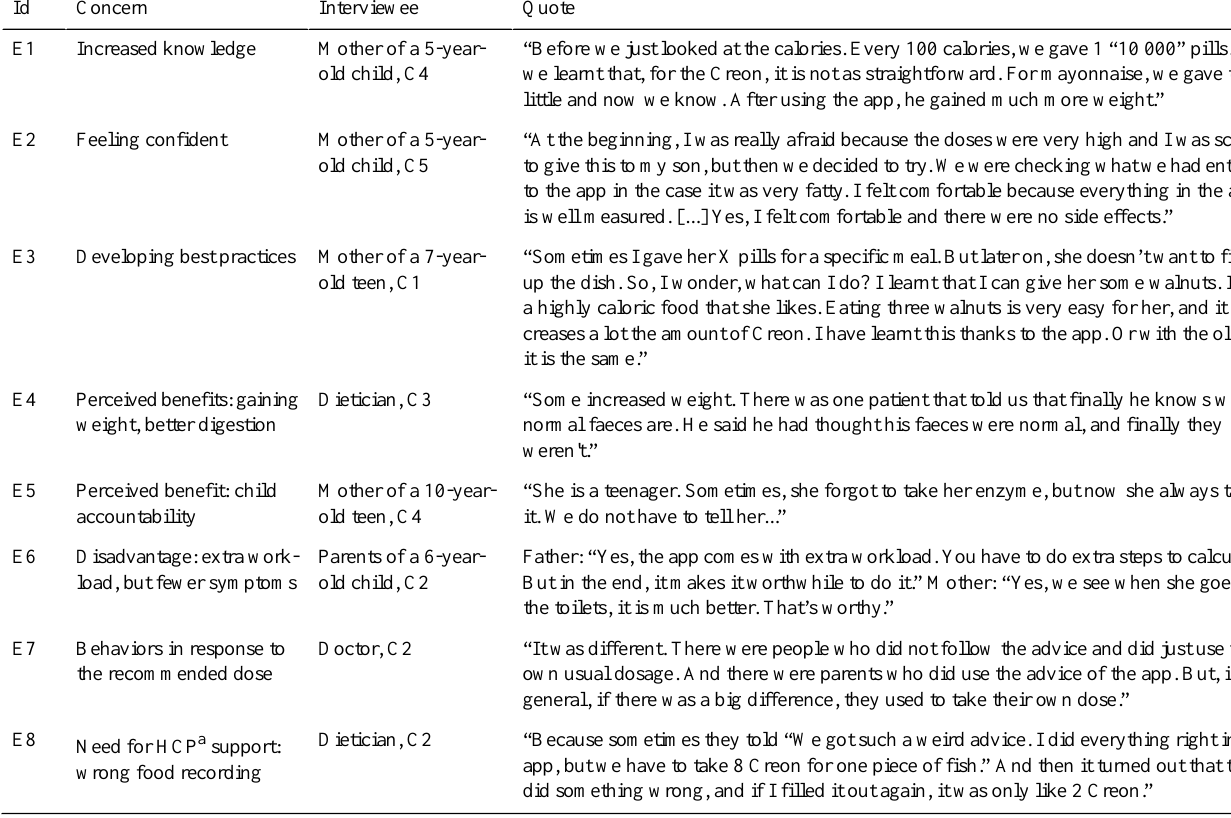
Table 4. Illustrative quotes related to using the self-management app: enzyme dose calculation.